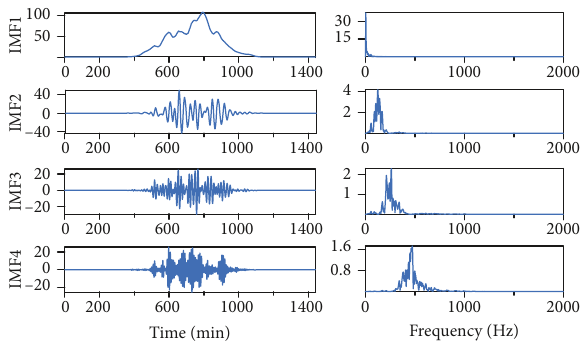
Figure 7: VMD decomposition